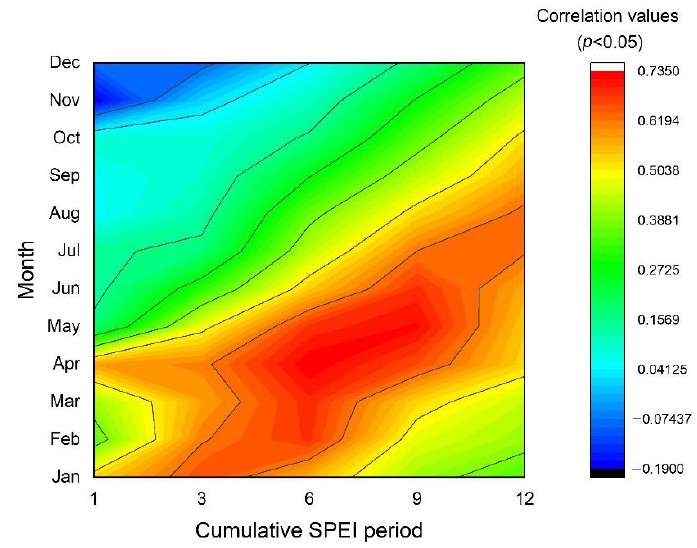
Figure 4. Drought – growth association calculated for Pinus durangensis by relating the SPEI drought index to the earlywood residual chronology. The value was assigned to the last month of the SPEI cumulative period.